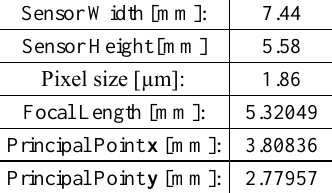
Table 2. Optimized values of the camera parameters